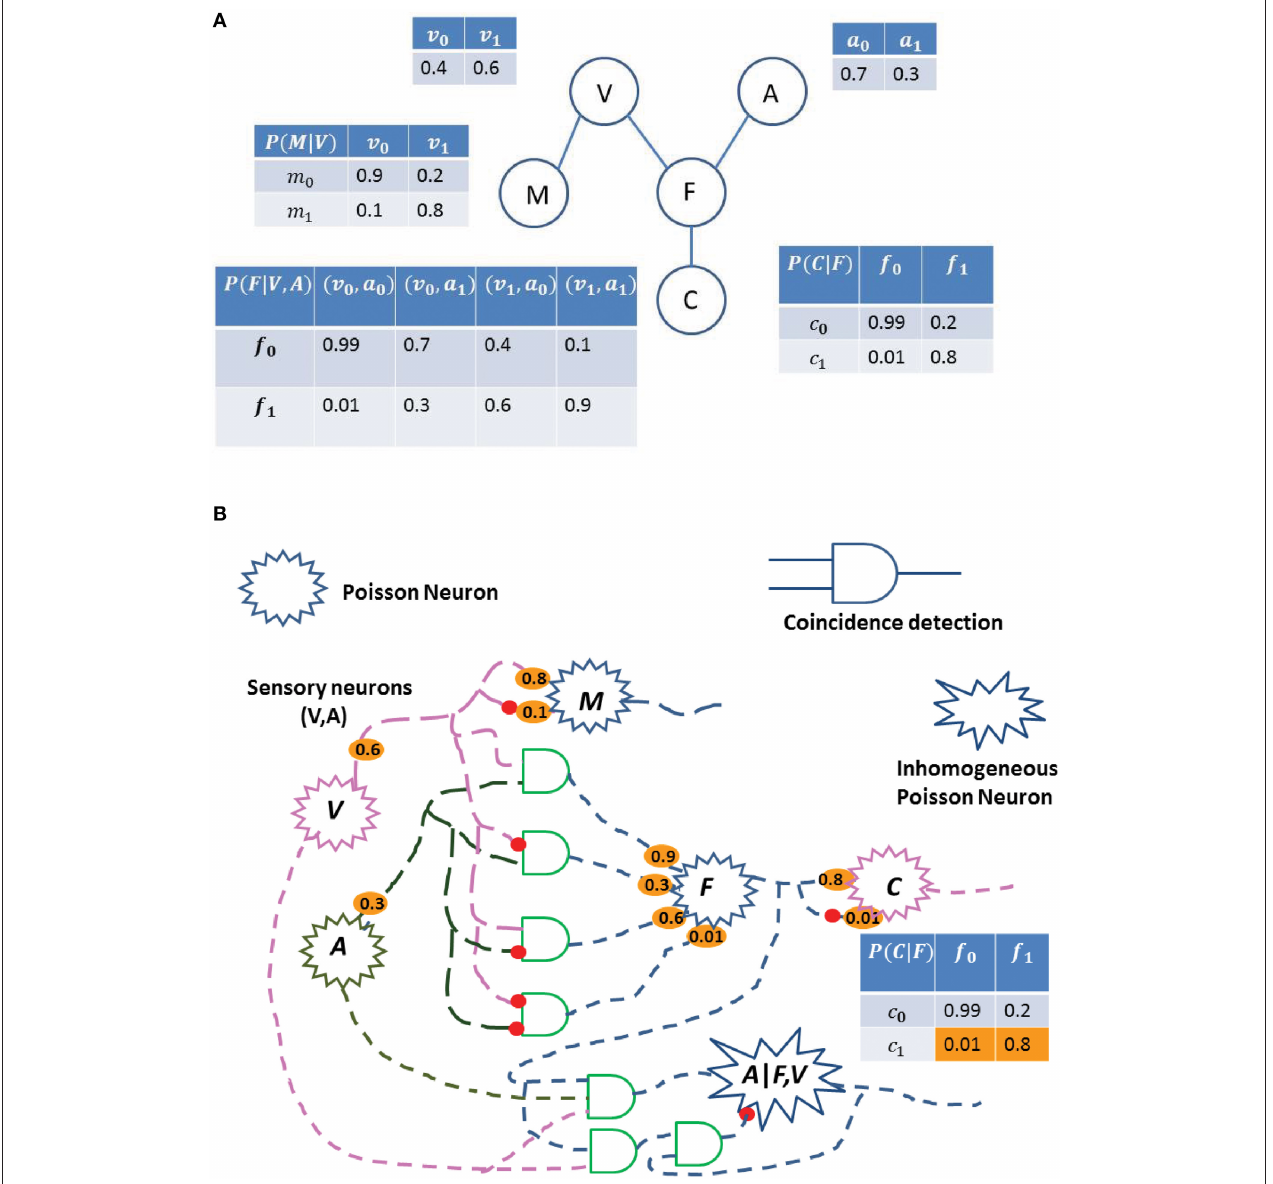
FIGURE 3 | Probability estimation in a simplified Bayes network. (A) A predator uses visual cues (V) to find a mate (M), and both visual (V) and auditory (A) cues to find food (F). C is the event of catching the food, F. Each table represents the probability of the event. Some of the events are conditional on other events, such as event (F) depends on (V) and (A). The subscript 0 with the variable represents the probability of the absence of the event, while the subscript 1 represents the probability of the event. For an instance, P ( f 1 | v 0 , a 1 ) = 0.3 means that the probability of finding the food given the auditory cue and absence of the visual cue is 0.3. (B) Possible neural circuit corresponding to the Bayes network shown in (A) . Each Poisson neuron represents a different random variable (Visual, Audition, Food, Catch, and Mate), and each synaptic connection is associated with the emission probabilities of a spike [non-spiking probability is 1-(spike probability)] shown in orange, and is related to the probability tables of ( Figure 6 ). The probability of a variable can be inferred from the multivariate joint distribution by taking multiple samples and considering only samples when spike occurs for that variable. By the law of large numbers, the estimation of the variable will be close to the true value. For an instance, circuit to compute the probability of variable A given F and V is